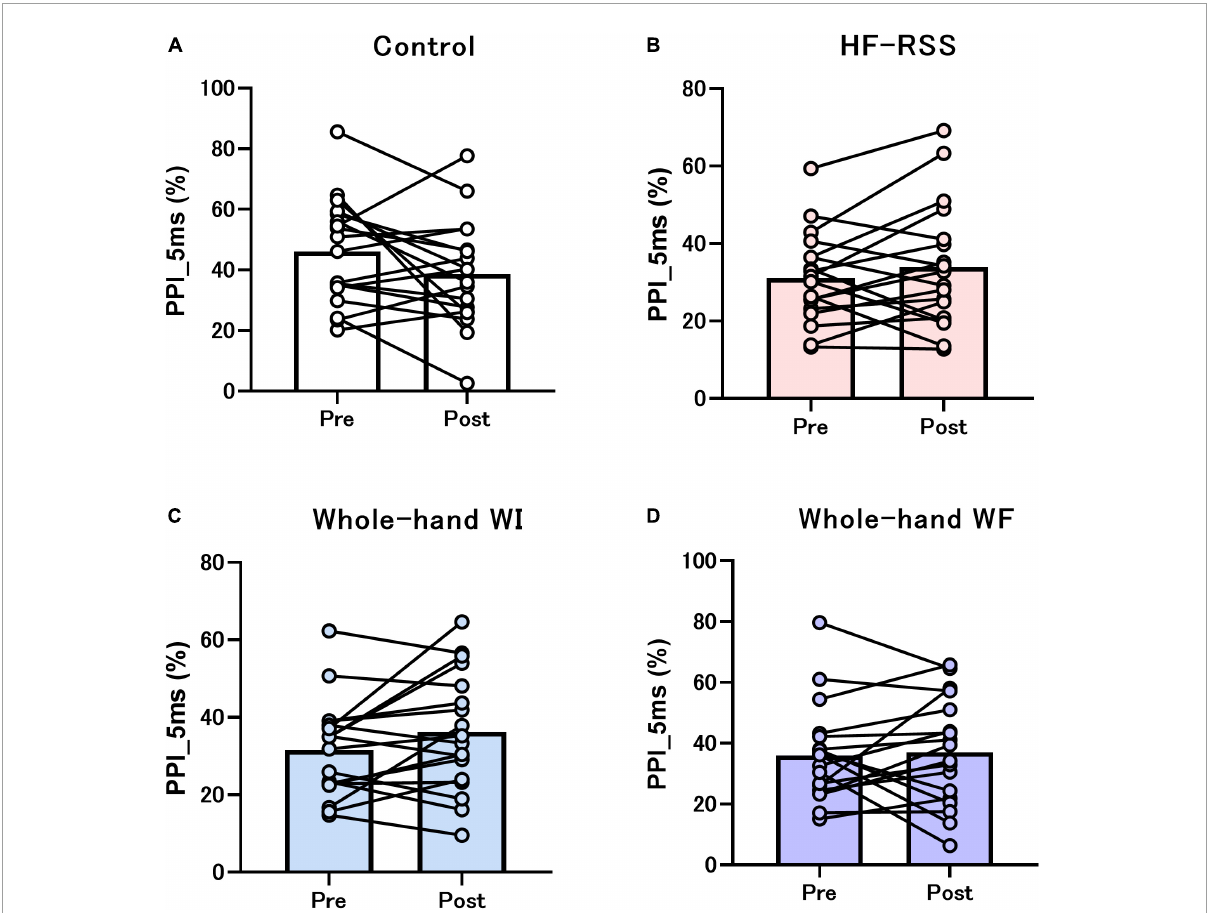
FIGURE5 PPI_5 ms of N20-P25 amplitude before and after each intervention: (A) Control, (B) HF-RSS, (C) Whole-hand WI, and (D) Whole-hand WF. Generalized linear mixed model revealed that there was no significant interaction or main effect of “intervention” and “time.” HF-RSS, high-frequency repetitive somatosensory